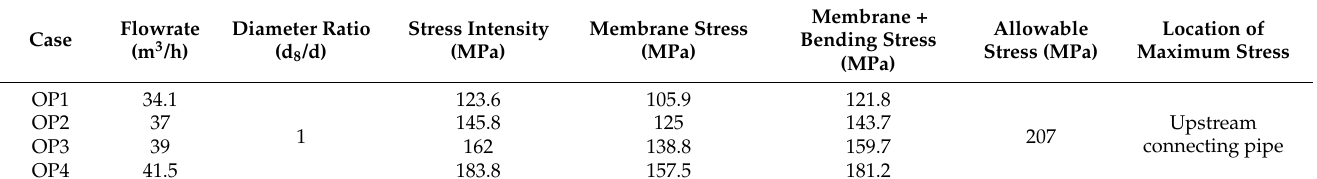
Table 6. The predicted results of stress components depending on the operating flow rate.